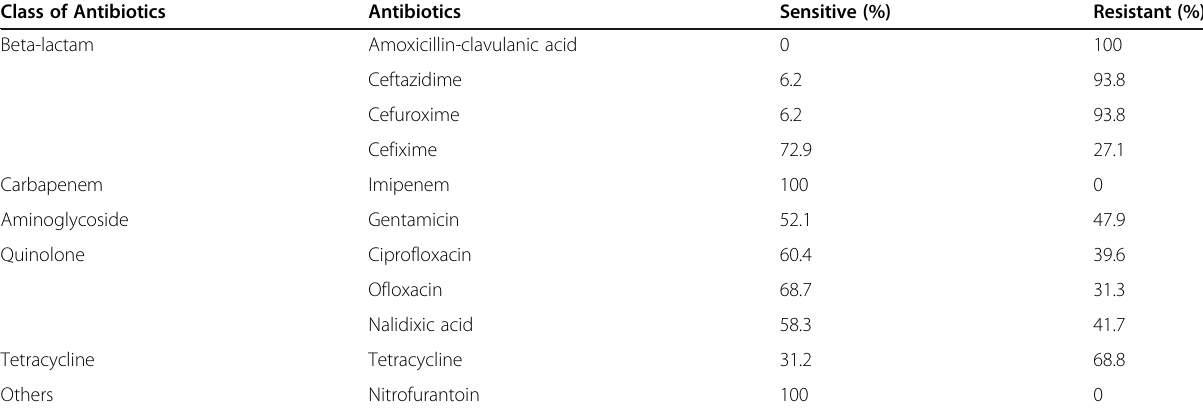
Table 2 Percentage Susceptibility of Isolates to Various Classes of Antibiotics Class of Antibiotics